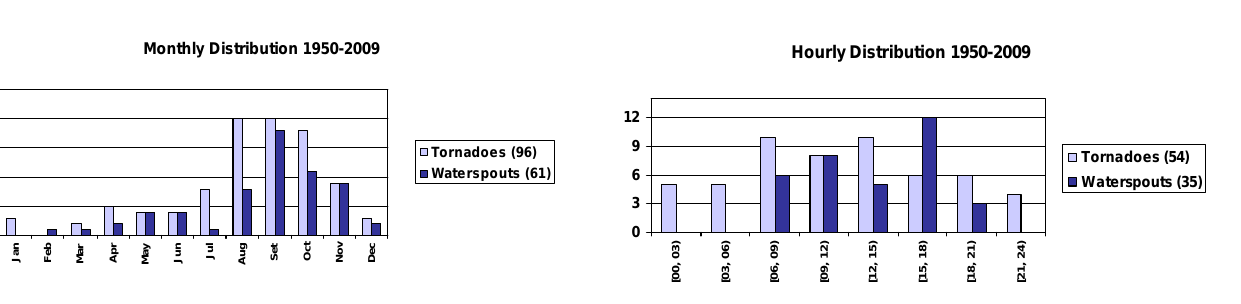
Fig. 5. Monthly distribution for tornadoes and waterspouts in the Fig. 6. Hourly distribution of tornadoes and waterspouts for which Figure 5. Monthly distribution for tornadoes and waterspouts in the complete period 1950-2009 complete period 1950–2009 in Catalonia. One tornado and one wa- Figure 6. Hourly distribution of tornadoes and waterspouts for which this information is in Catalonia. One tornado and one waterspout from the total sample cannot be classified due to this information is available terspout from the total sample cannot be classified due to the lack the lack of information. available (1950-2009) of information.